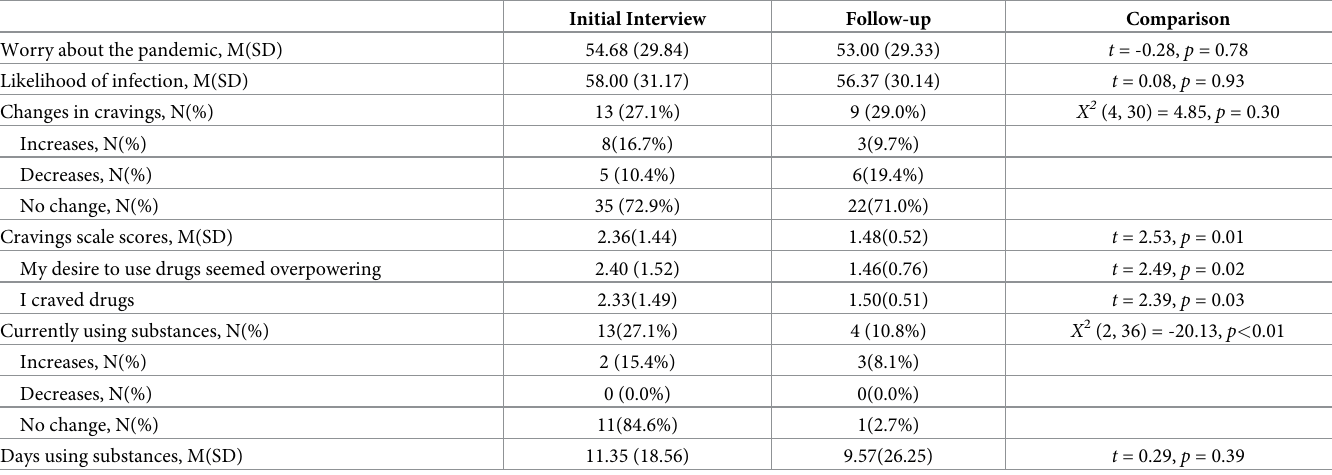
Table 2. Management of recovery at initial interview and